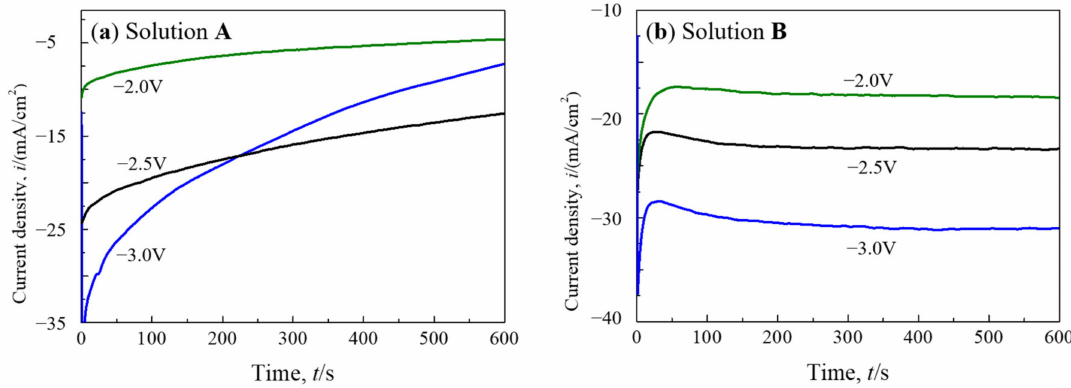
Figure 2. Potentiostatic chronoamperometry curves on a Cu plate at applied potentials of − 2.0 V, − 2.5 V, and − 3.0 V (vs. SSE) in solutions A ( a ) and B ( b